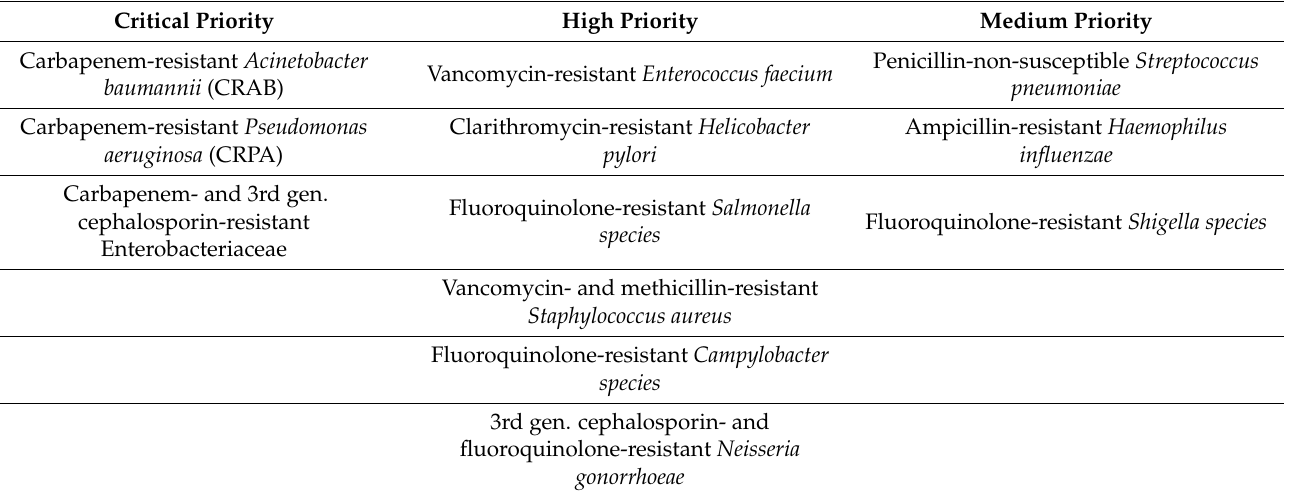
Table 2. The WHO priority pathogen list [10].